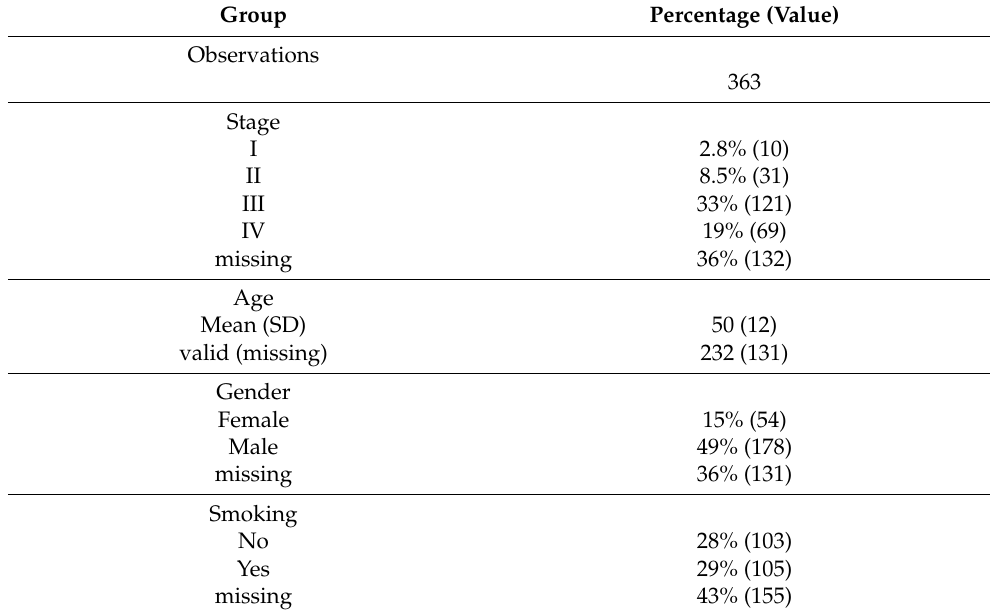
Table 1. Clinical table for our cohort. Group Percentage